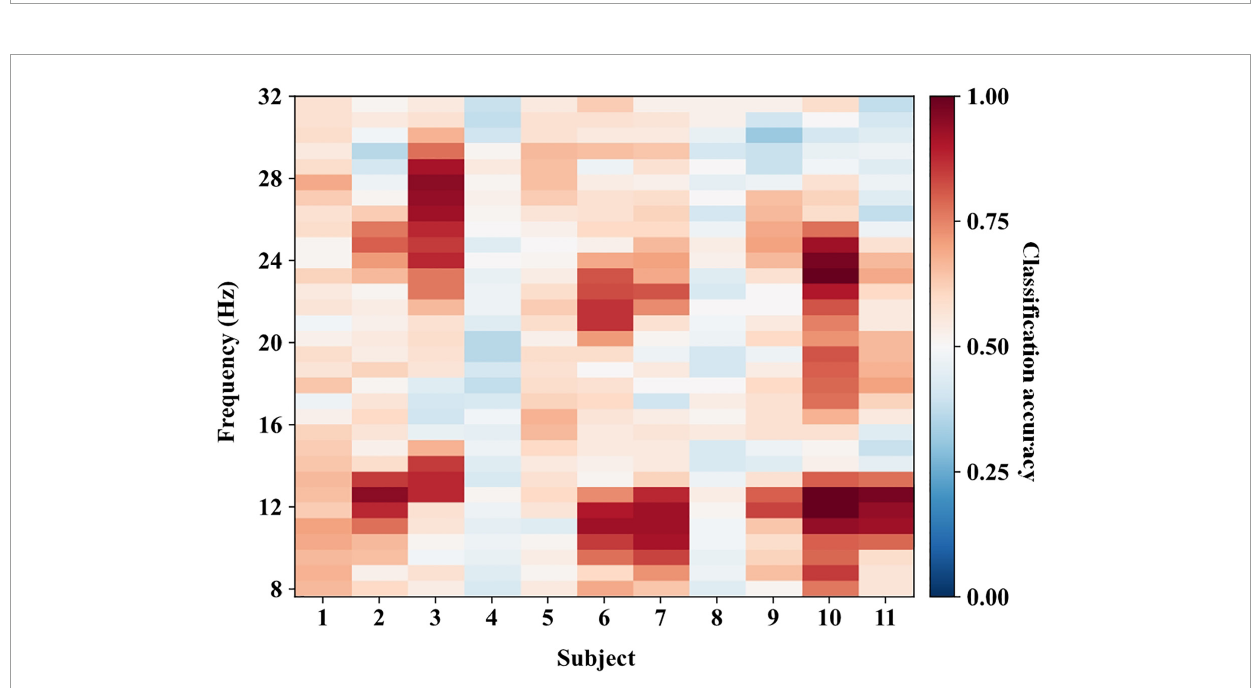
FIGURE6 The classification performance in the calibration process of experiment one. We calculated the classification accuracies using calibration data at all frequency points. The frequency points with the highest classification accuracy are selected as the optimal frequency points for each subject.